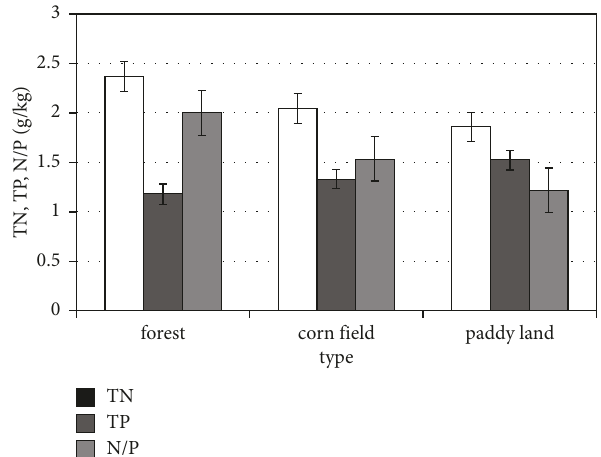
Figure 4: Comparative analysis of soil TN, TP content, and N/P in different land-use